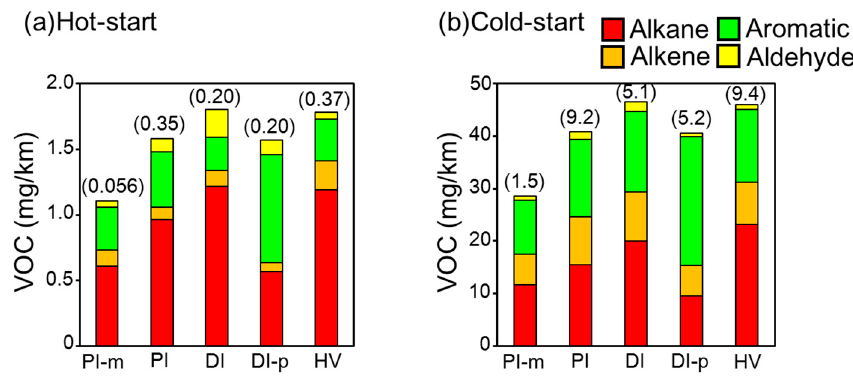
Figure 4. Normalized average VOC emissions by each vehicle type for a hot-start ( a ) and cold-start ( b ). Values in parentheses represent the standard deviation for each vehicle type.